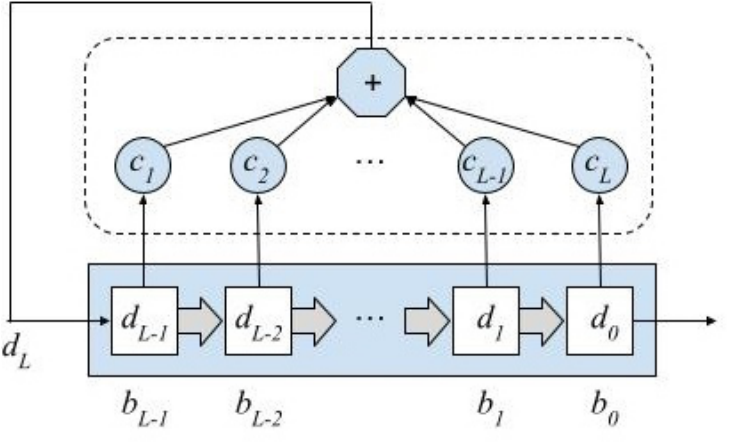
Figure 1. Linear feedback shift